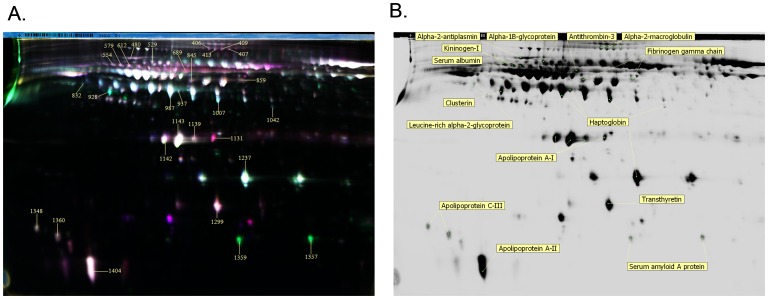
2D-DIGE analysis of the protein spots were differentially expressed between the severe HFMD groups and the healthy controls.(A) The proteins extracted from the HFMD and control samples were labelled with Cy3 and Cy5, respectively. An internal standard protein sample (a mixture of severe HFMD and control samples) was labeled with the Cy2 dye. The green spots represent up-regulated proteins, while the red spots represent down-regulated proteins in the severe HFMD samples compared with the control samples. The yellow arrow represents the identified spots that showed significantly different expression between the severe HFMD and control samples. The number in the figure corresponds to the master number presented in Tables 2. (B) Differentially expressed proteins identified in 2-DE gels.